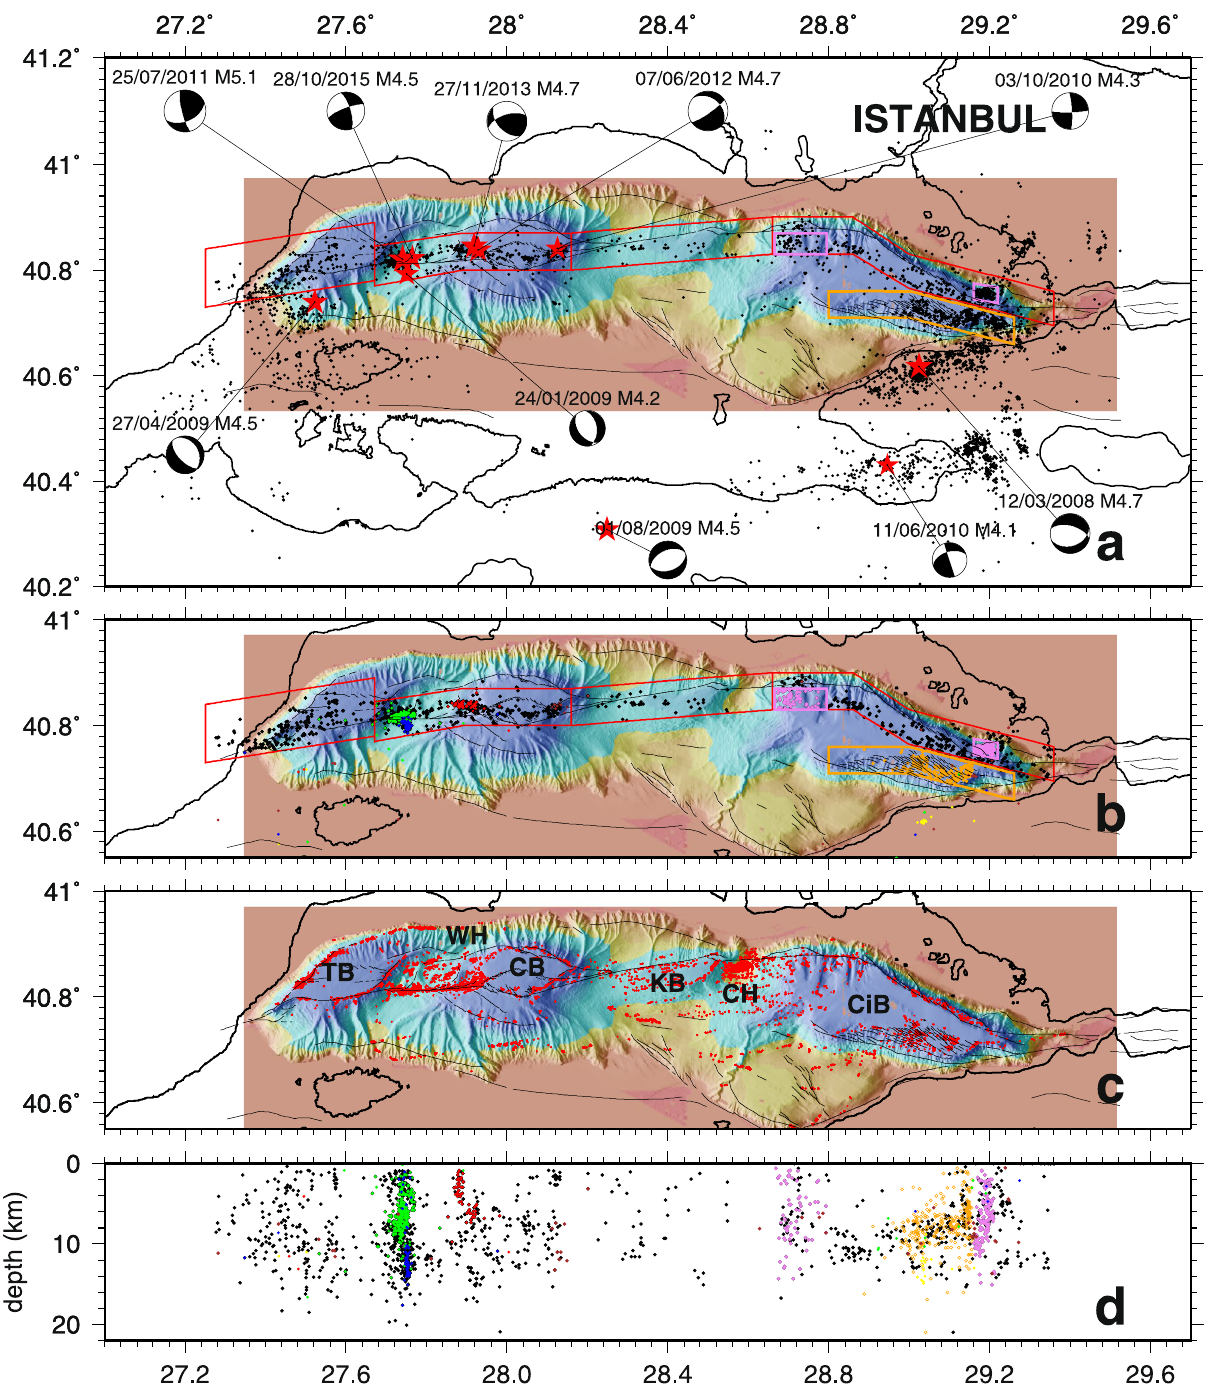
Figure 1. Seismicity (after ref. 8 ) and gas emissions within the Sea of Marmara. ( a ) Full seismicity map from 2007 to 2012 based on the recordings from 132 land stations, as well as from temporary seabottom networks, including 5 cabled observatories from 2009 to 2011 and 10 autonomous stations deployed by Ifremer from april 2011 to july 2011 (see location of stations in ref. 8 ). The Western Sea of Marmara is regularly affected by earthquakes of magnitude > 4.5. The two earthquakes of magnitude > 4.0 which occurred in 2013 and 2015 were therefore added to complete the general pattern of seismicity in this area (locations from KOERI catalog). For all maps, thin black lines indicate major structural features, from ref. 3 . ( b ) Selected micro-earthquakes with epicentres located within the boxes shown in panel A, respectively centered along the MMF and within the southern part of the Cinarçik Basin. Coloured dots indicate those aftershocks that occurred within the Western Sea of Marmara, 7 days after the earthquakes of magnitude > 4 (years 2007 to 2012 only). Blue: 27/04/2009; pink: 03/10/2010; red: 25/07/2011; green: 07/06/2012. ( c ) Sites of acoustically detected gas emissions (red dots), from ref. 22 . TB: Tekirdag Basin. WH: Western High; KB: Kumburgas Basin; CH: Central High; CiB: Cinarçik Basin. Note that in the Central High and the in the Kumburgas basins, gas is not found within the